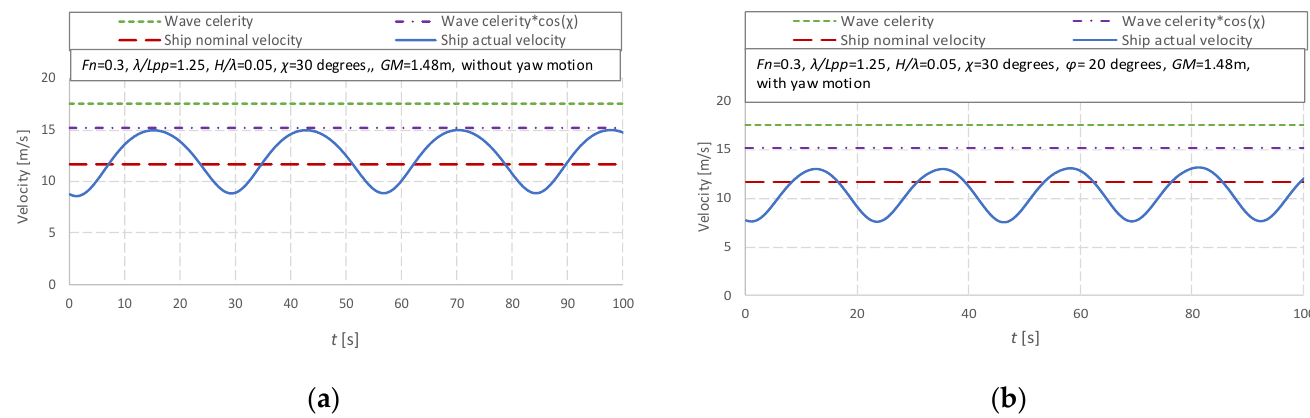
Figure 3. Comparison between ship velocity without/with the yaw motion and wave celerity, ( a ) without the yaw motion; ( b ) with the yaw motion.